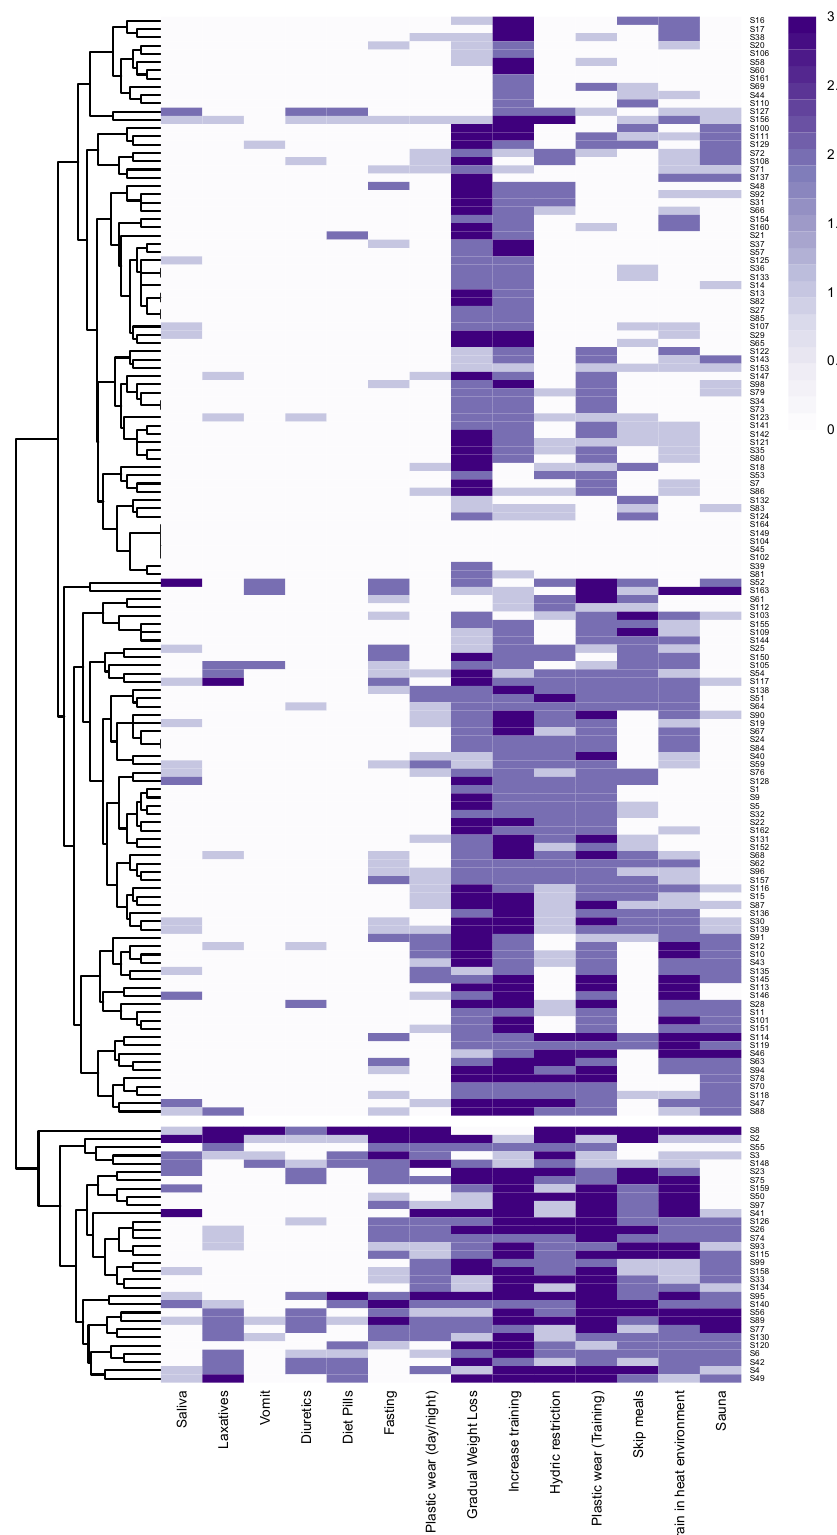
Figure 1. Heatmap with weight-cutting strategies (in columns) and subjects (in rows). An empty line separates the two clusters (Cluster 1 at the top, Cluster 2 at the bottom). White colour is associated with the ‘never used’ answer, while purple represents the ‘always’ answer.